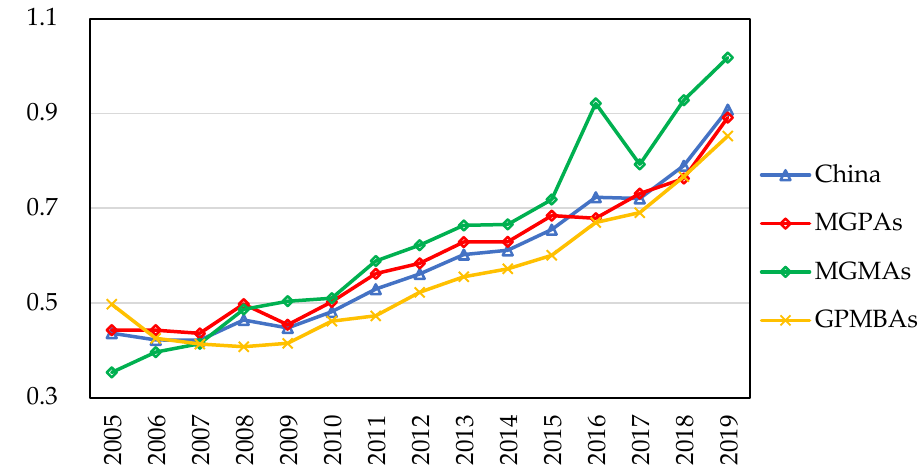
Figure 4. Average value of CLGUE in China, MGPAs, MGMAs, and GPMBAs.